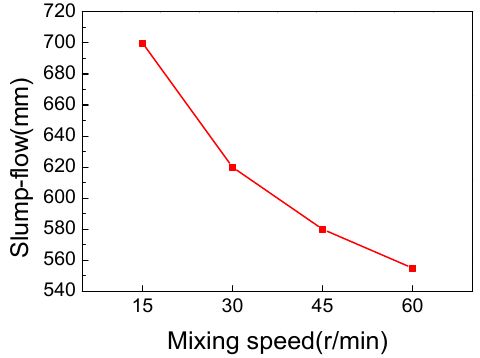
Figure 8. E ff ect of mixing speed on the slump-flow of SCC. Figure 8. Effect of mixing speed on the slump-flow of SCC.